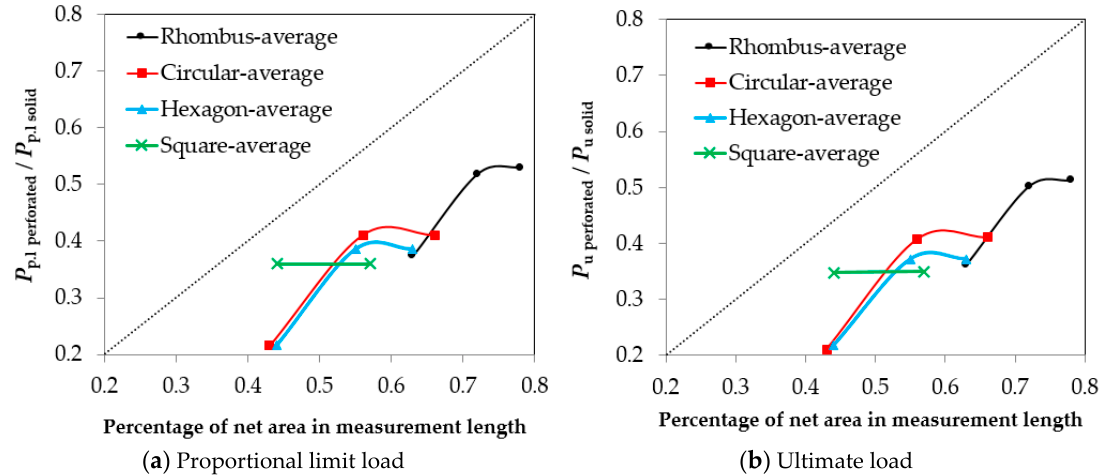
Figure 15. Relation between the ratio of perforated steel sheets applied loads to control solid steel sheets and the percentage of net area.